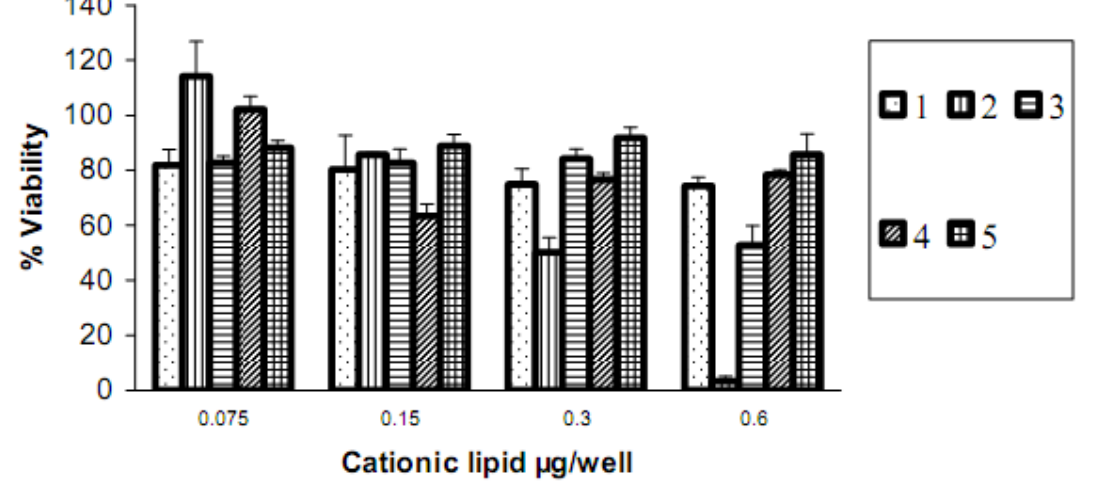
Figure 8. Upper : Cell viability alamarBlue assay of fatty acid amides of spermine at different cationic lipid/siRNA ratios. siRNA concentration is kept constant at 1.5 pmol/well (n = 6). Lower : Comparison of cell viability of HeLa cells after transfection with fatty acid amides of spermine at their optimal cationic lipid/siRNA ratios and compared with the commercially available transfection agents Lipofectamine 2000 and TransIT TKO Values are presented as mean ± SD (n = 6) using erucoyl (0.6 m g/well), linoleoyl (0.15 m g/well), oleoyl (0.6 m g/well), and stearoyl (0.6 m